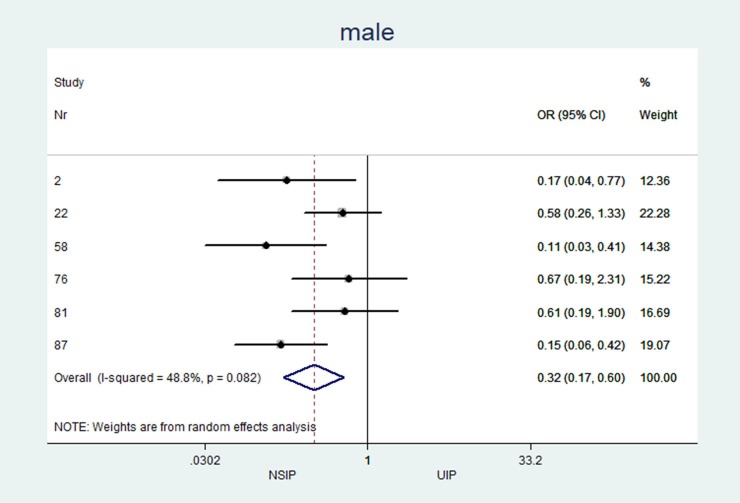
Male distribution.